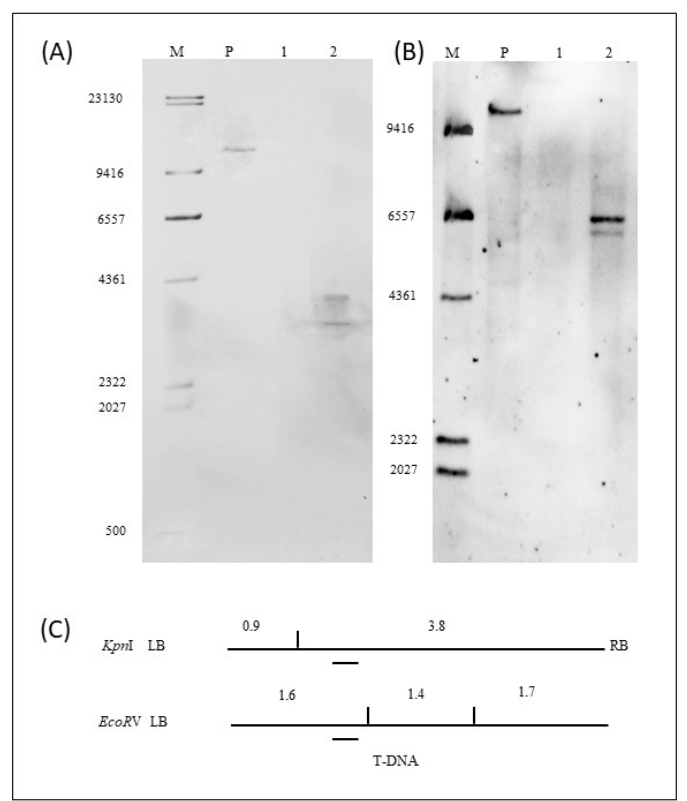
Figure 4. Southern hybridization image of Bar gene digested by Kpn I ( A ) and EcoR V ( B ), and a schematic diagram of restriction enzyme site and probe location of T-DNA ( C ). In ( A , B ): image, M, DNA Marker III (bp), DIG-labeled (Roche); P, positive control of Hs1 pro − 1 gene plasmid DNA; 1, the NT ‘ Tianlong 1 ’; 2, T5 ZHs1-2 transformation event genomic DNA. In ( C ), the vertical lines designate the location of the restriction enzyme site digestion and the digested band size (bp); the short dashes indicate the location of the hybridization